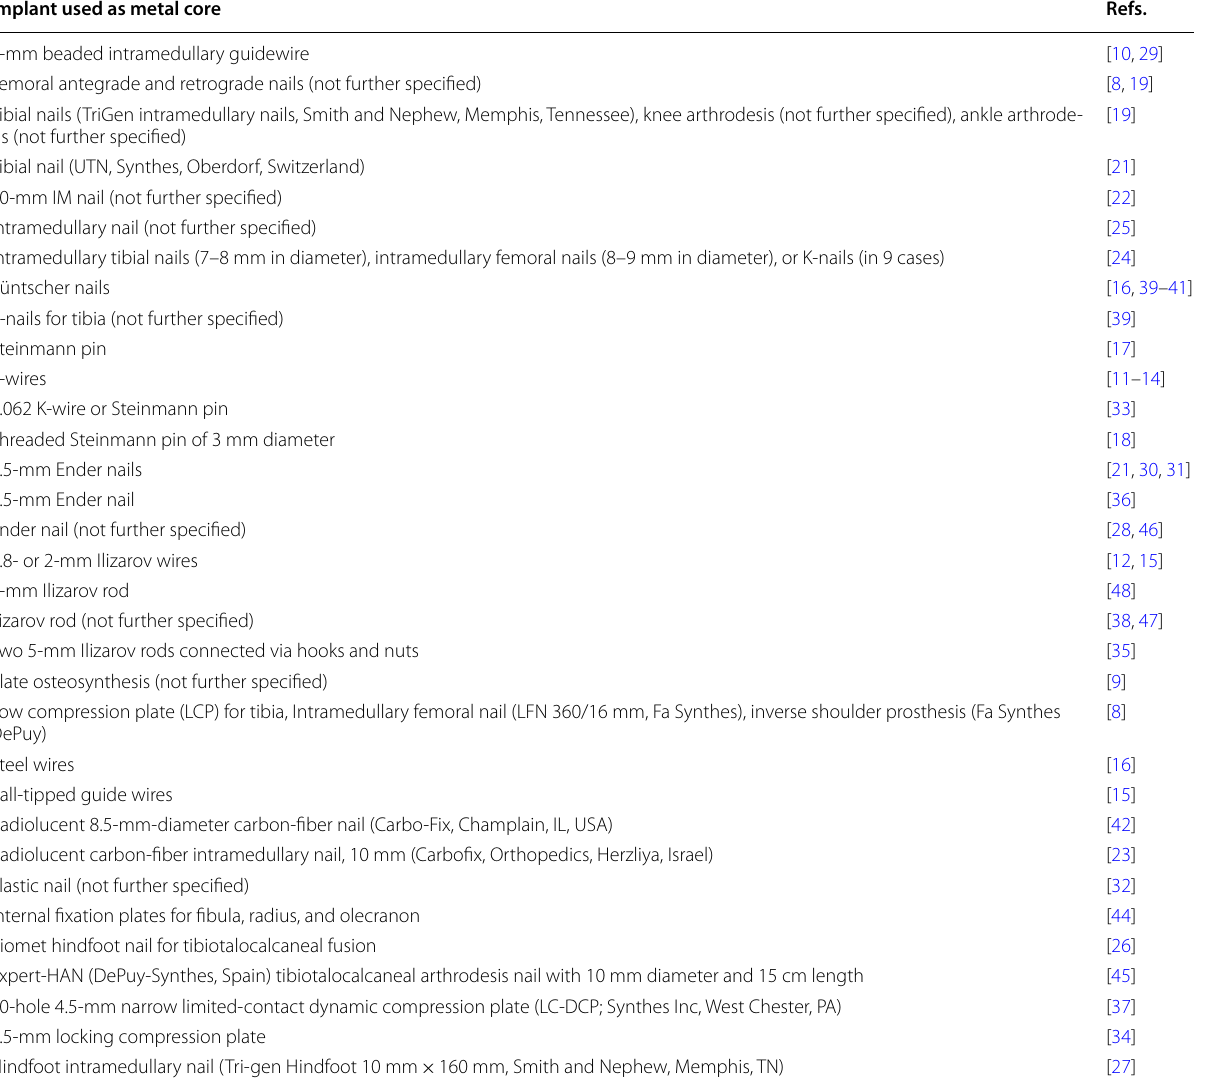
Table 3 Various implants used Implant used as metal core Refs. 3-mm beaded intramedullary